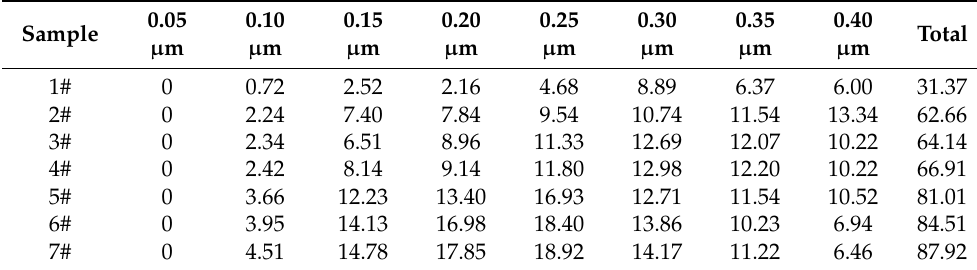
Figure 5. Grain size distribution and average grain size of WC–6Co–(Cr 2 C 3 /VC) cemented carbides. ( a ) WC–6Co; ( b ) WC–6Co–0.25Cr 3 C 2 ; ( c ) WC–6Co–0.6Cr 3 C 2 ; ( d ) WC–6Co–1.0Cr 3 C 2 ; ( e ) WC–6Co–0.25VC; ( f ) WC–6Co–0.6VC; ( g ) WC–6Co–1.0VC and ( h ) mean grain size. Table 2. Proportion and total amount of 0.05–0.4 μ m grains in samples 1#–7# (%).